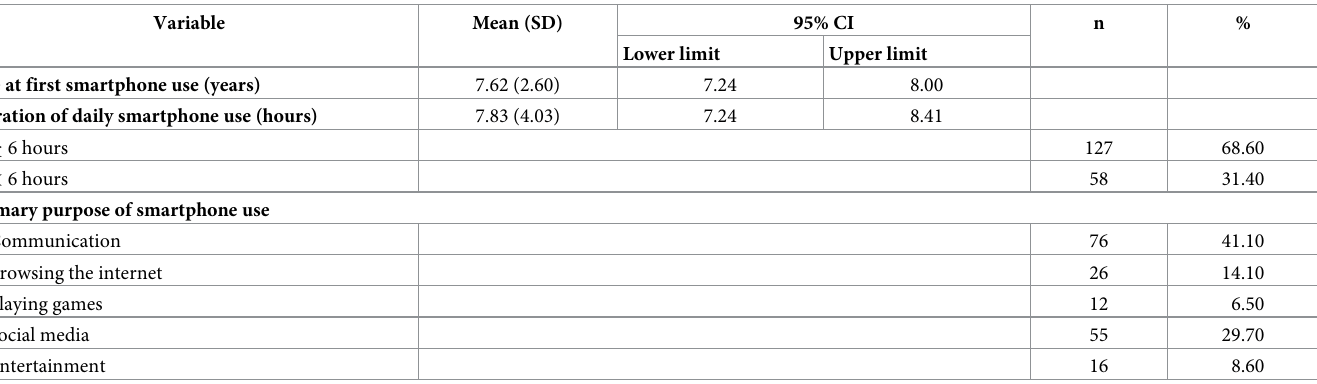
The temperament profile of the participants The mean scores for the three dimensions of temperament, namely, NS, RD, and HA were 11.56 (SD = 1.89), 9.36 (SD = 1.69), and 11.74 (SD = 1.88), respectively. Those who obtained scores that lay above these mean scores were classified as “high” with regard to the respective dimension of temperament. More than 50% of the participants were classified as “low” with regard to NS and as “high” with regard to RD and HA (Table 4). Table 2. Smartphone use among